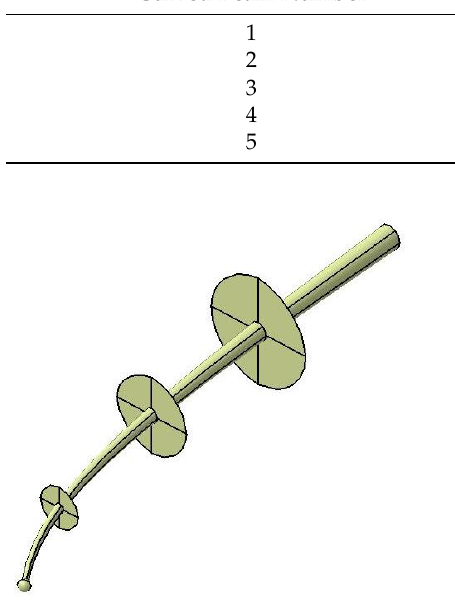
Figure 12. Curved beam – planar disk.